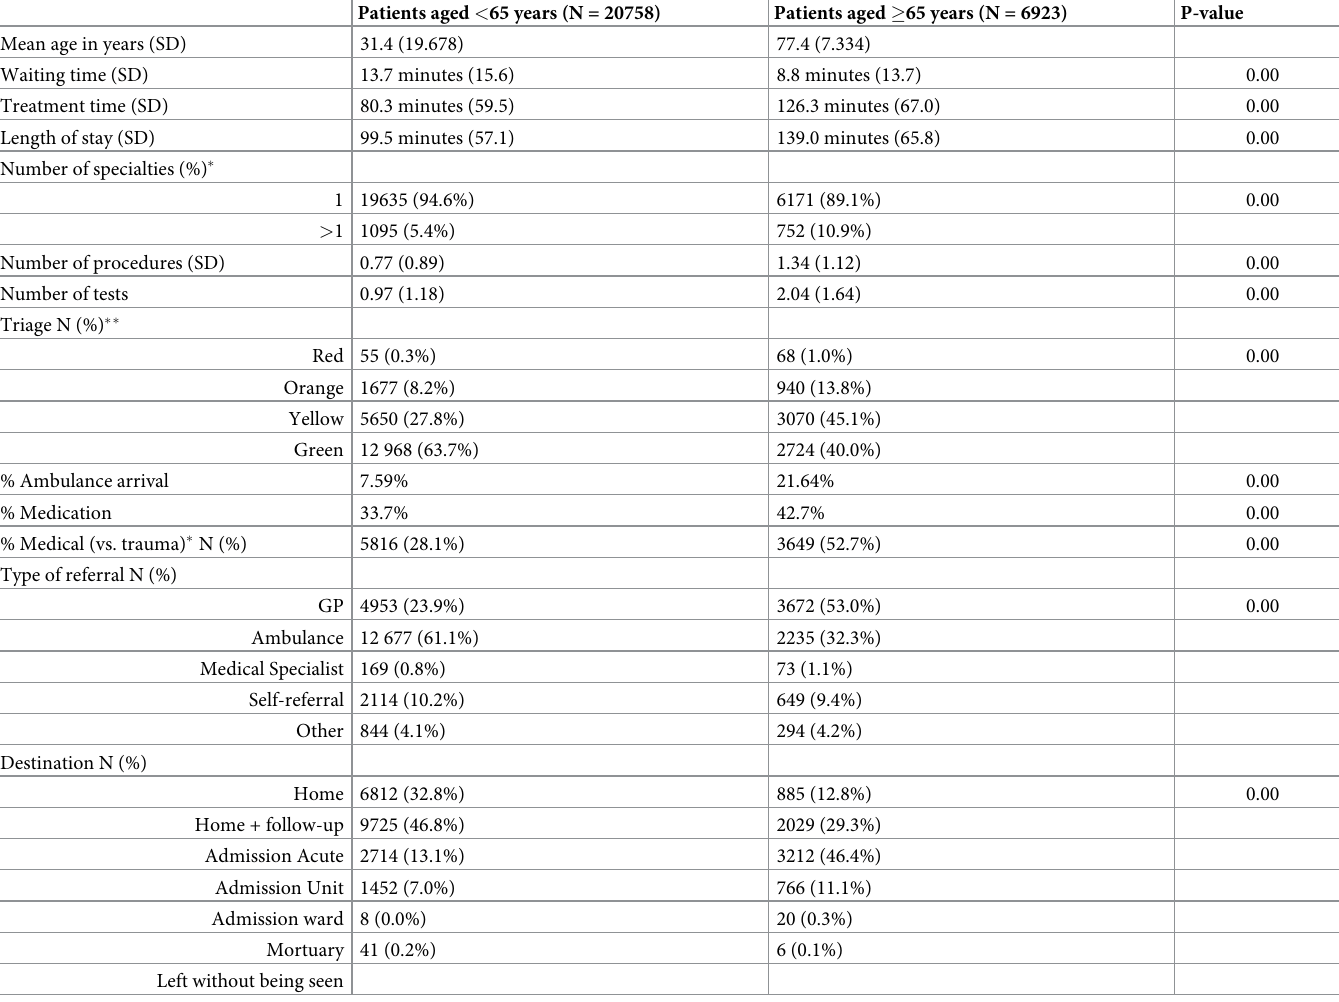
Table 1. Comparison of < 65 and � 65 years patients. P-values are obtained by performing χ 2 tests for the categorical variables (triage, type of referral and destination) and independent t-tests for the other